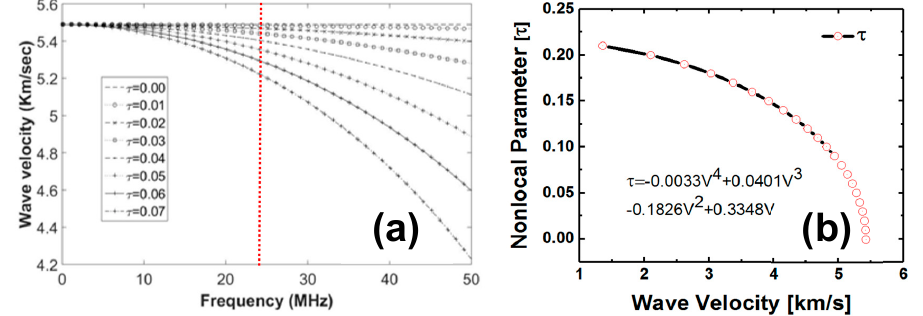
Figure 3. ( a ) Dispersion of quasi-longitudinal wave mode in carbon-fiber composite specimen; ( b ) variation of the nonlocal parameter at ~25 MHz.